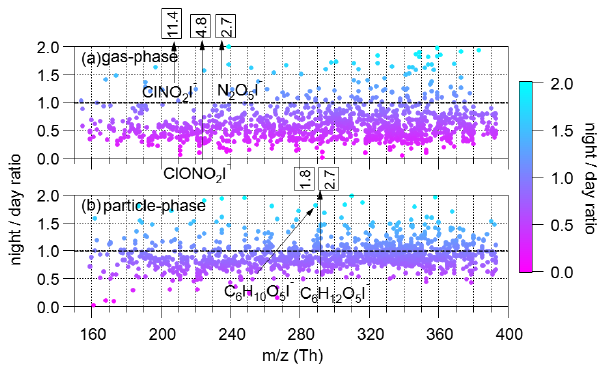
Figure 2. The ratios of concentrations at night (22:00–06:00) to concentrations during the day (10:00–18:00) for ions ranging from 150 to 400Th in the gas phase (a) and the particle phase (b) . The range of the y axis is set between 0 and 2 for clarity, although the ratios of some compounds are larger than 2. The numbers in boxes indicate the night / day ratios of tagged ions that exceed the y -axis